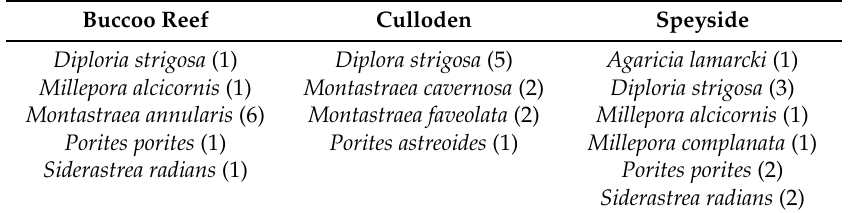
Table 2. Taxa and number of colonies surveyed (total 10) at the three reef sites in Tobago.